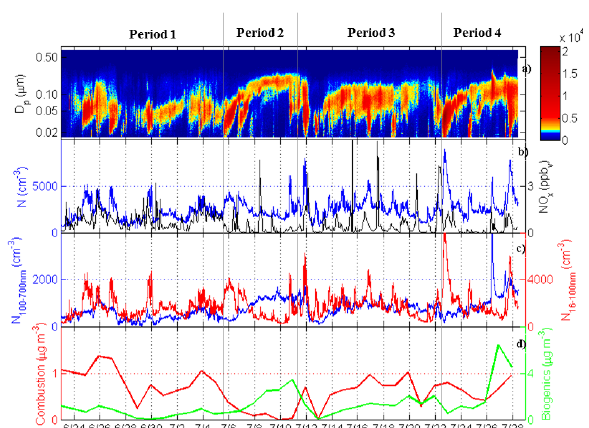
1120 1121 Fig. 9. Time series at Raven’s Nest of (a) SMPS particle num- Fig. 9. Time series at Raven’s Nest of (a) SMPS particle number size distribution (the color 1122 indicates dN/dlog 10 D p [cm -3 ]), (b) SMPS total integrated particle number concentration (blue) 1123 ber size distribution (the color indicates dN/dlog 10 D p [cm − 3 ]), and NO x concentration (black), and (c) N 100 (blue) and N 16-100 (red), and (d) the PMF 1124 (b) SMPS total integrated particle number concentration (blue) combustion factor (red) and biogenic factor (green). 1125 and NO x concentration (black), and (c) N 100 (blue) and N 16 − 100 (red), and (d) the PMF combustion factor (red) and biogenic factor (green).